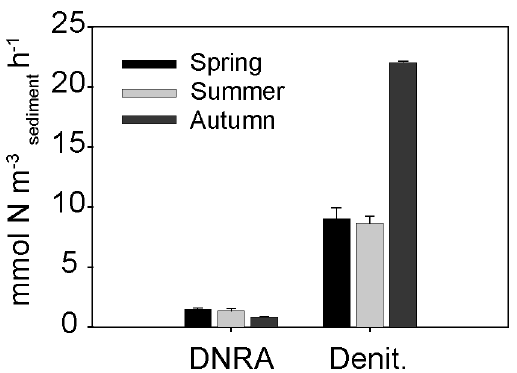
Figure 2. Rates of nitrogen cycling processes determined over 3 seasons. Anaerobic dissimilatory nitrate reduction to ammonium (DNRA) and denitrification (Denit.) rates from the incubation amended with 15 NO 3 2 . Rates were determined from linear production slopes after oxygen had been consumed. Error bars are SD